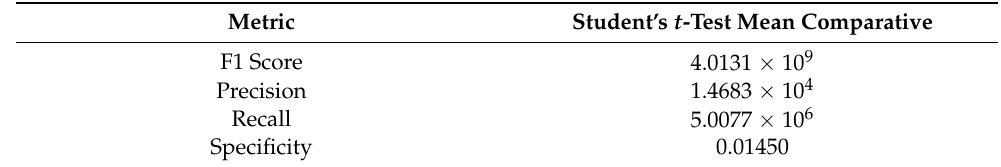
Table 14. Mean comparison hypothesis test for Pascal Dataset dataset.